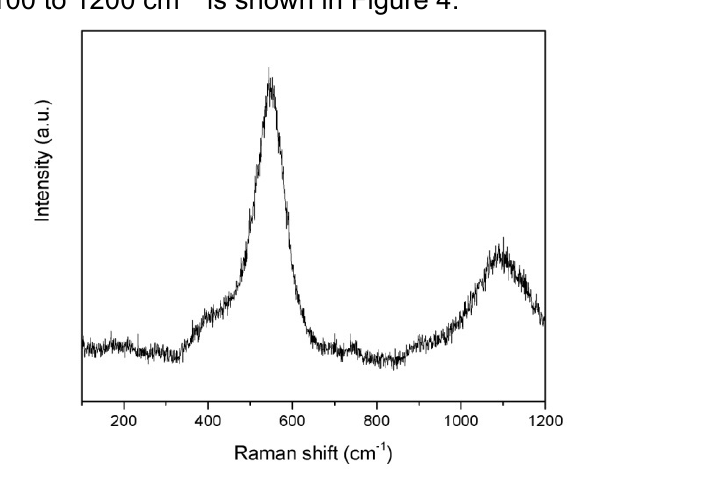
Figure 4 – Raman spectrum of the sample prepared without using